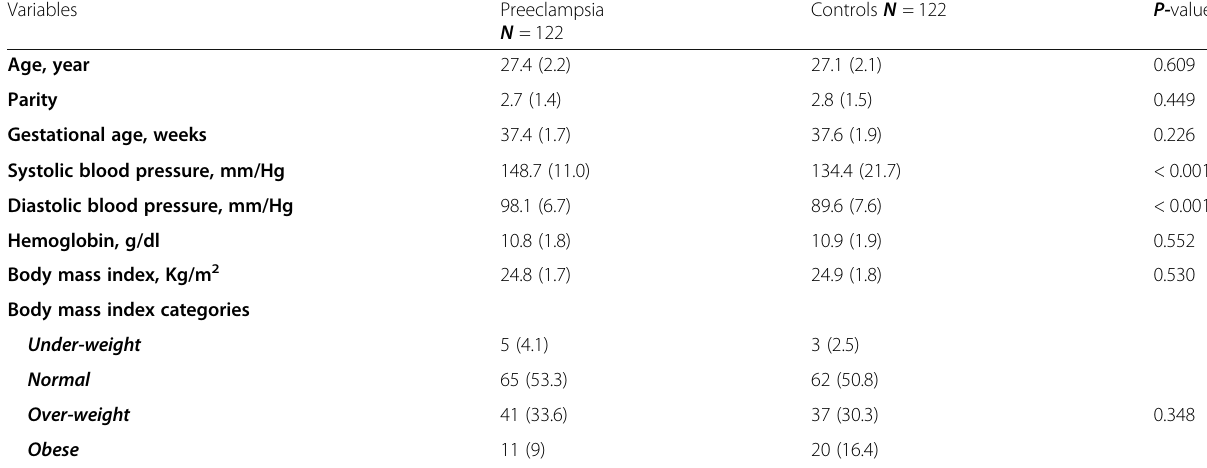
Table 1 The mean (SD) or n (%) of the basic characteristics between women with preeclampsia and the controls